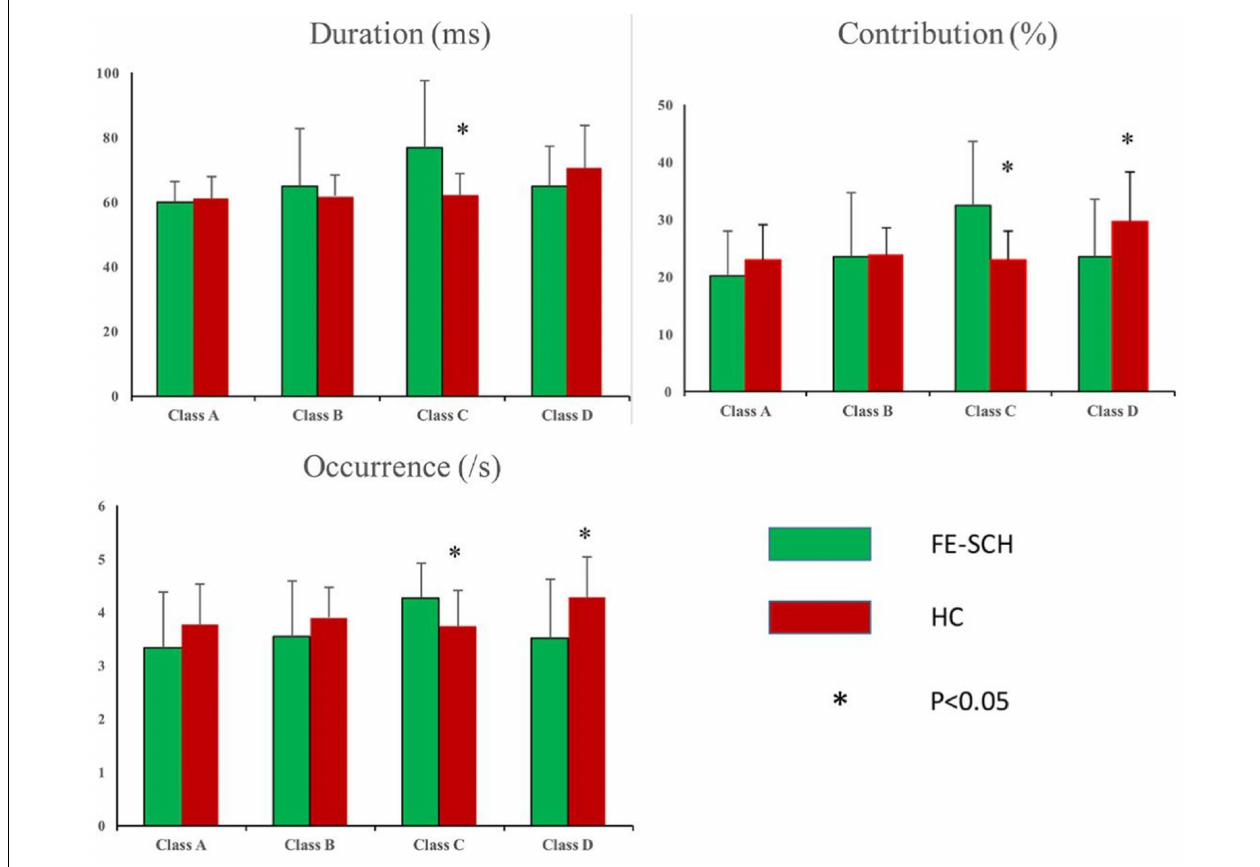
FIGURE 3 | Inter-group comparison of microstate parameters: duration, contribution, and occurrence. FE-SCH, drug-naïve, first-episode schizophrenia; HC, healthy